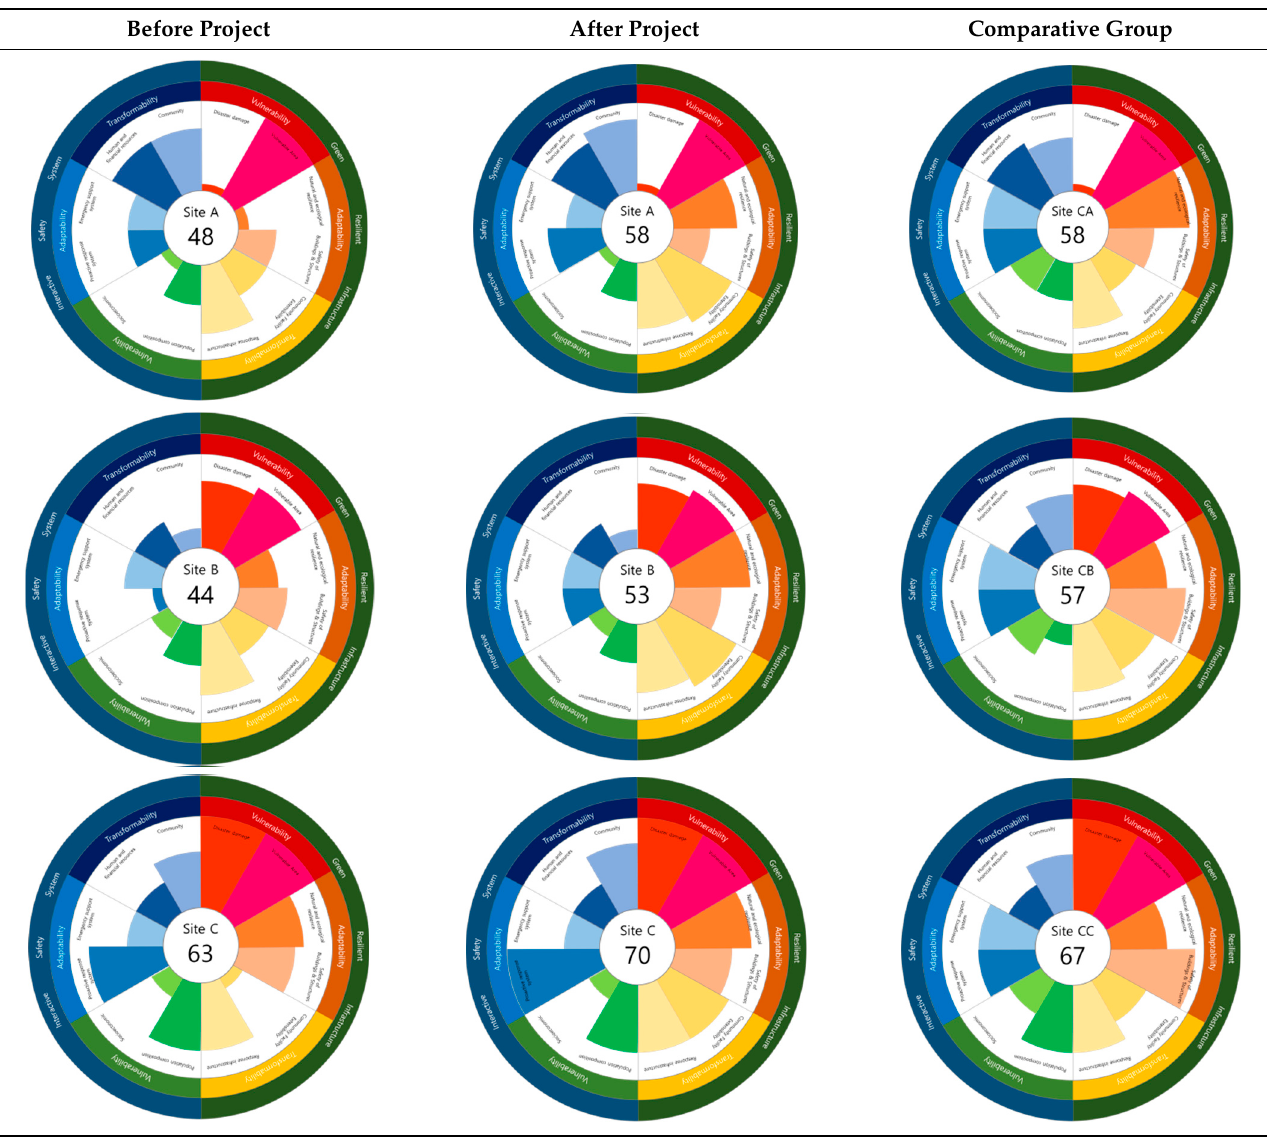
Table 5. The comparison of urban resilience index.